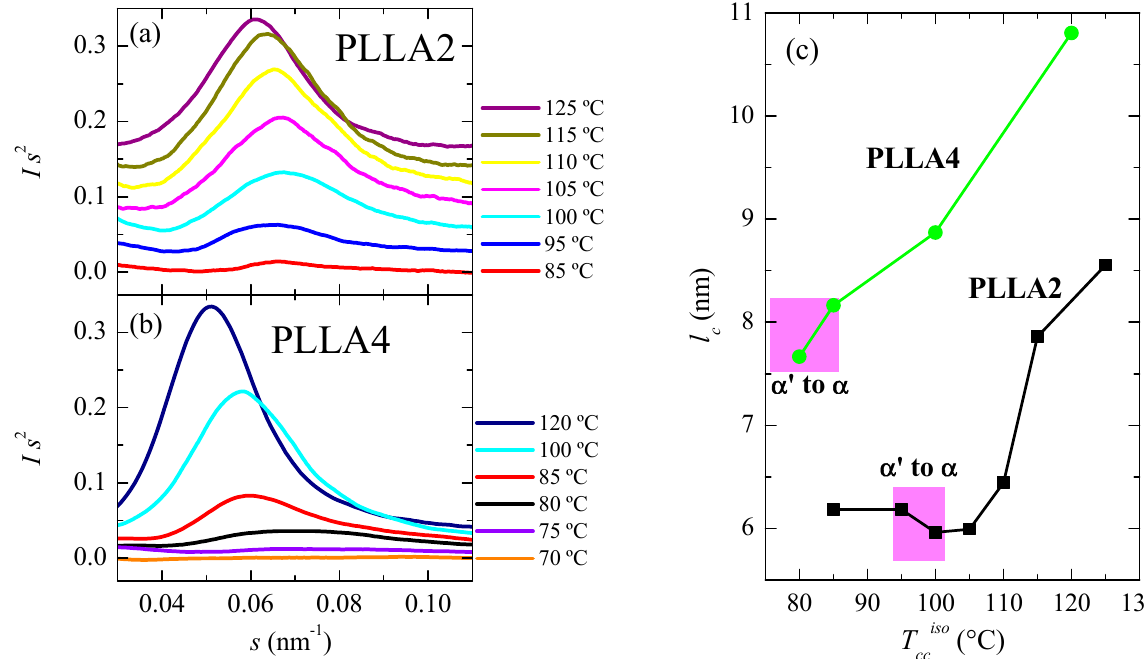
Figure 11. SAXS profiles, at room temperature, for different cold crystallized temperatures: ( a ) for PLLA2 and ( b ) for PLLA4. ( c ) Dependence of most probable crystallite size on isothermal cold crystallization temperature for PLLA2 and PLLA4, estimated from SAXS long spacing values assuming a two-phase model ( l c = L SAXS × f c WAXS ).